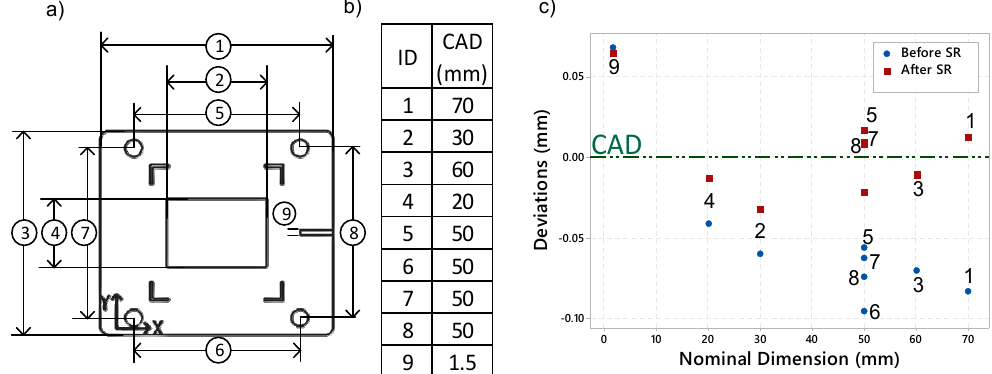
Figure 4. ( a ) Calibration part inspection plan, ( b ) nominal values of the inspected features, and ( c ) inspection results .